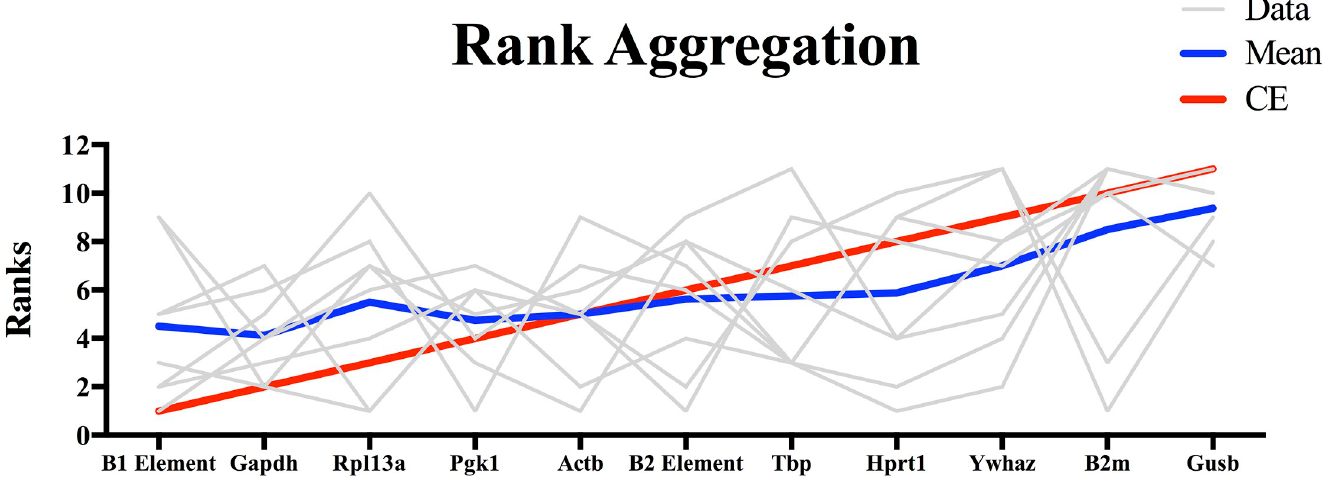
Fig 4. The rank aggregation consensus result of the reference genes and B elements via the performance of the Cross-Entropy (CE) Monte Carlo algorithm in combination with the Spearman’s foot-rule weighted distance.